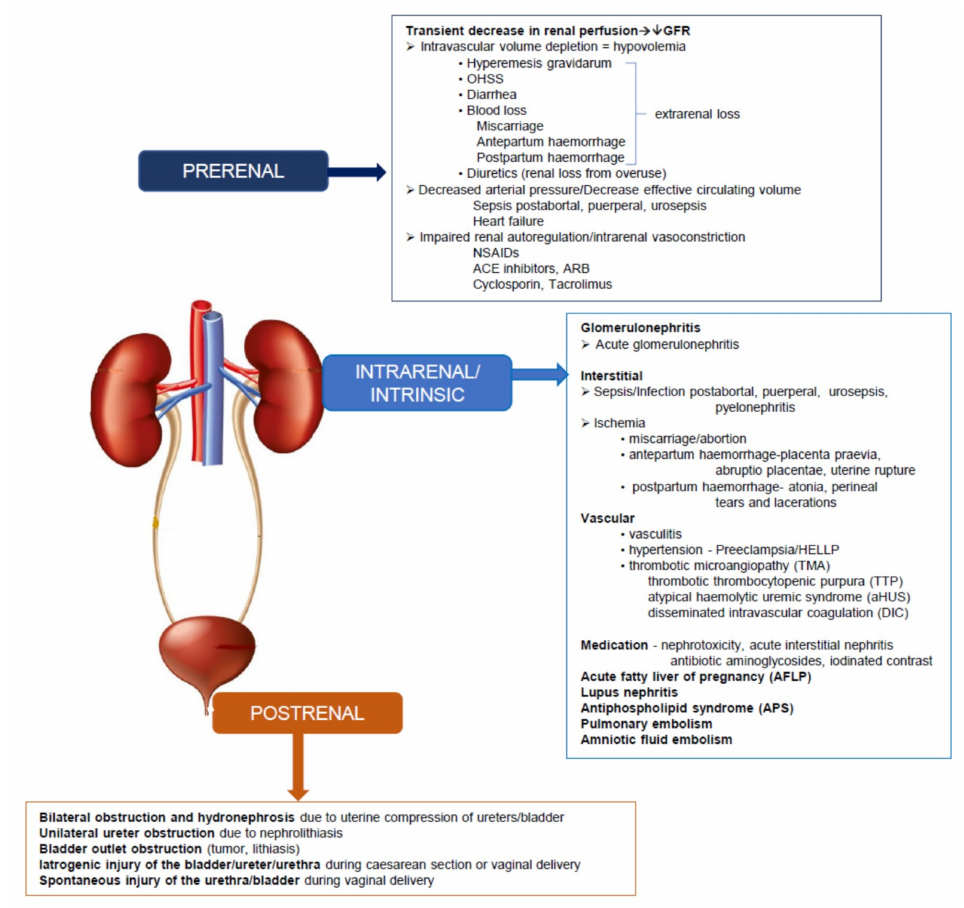
Figure 2. Common causes of pregnancy-related (PR)-AKI classified by a physiopathological mechanism of kidney